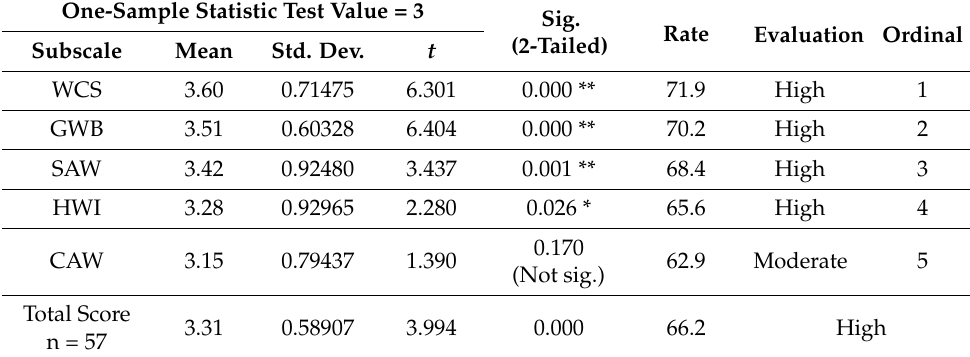
Table 2. QWL By Subscale.